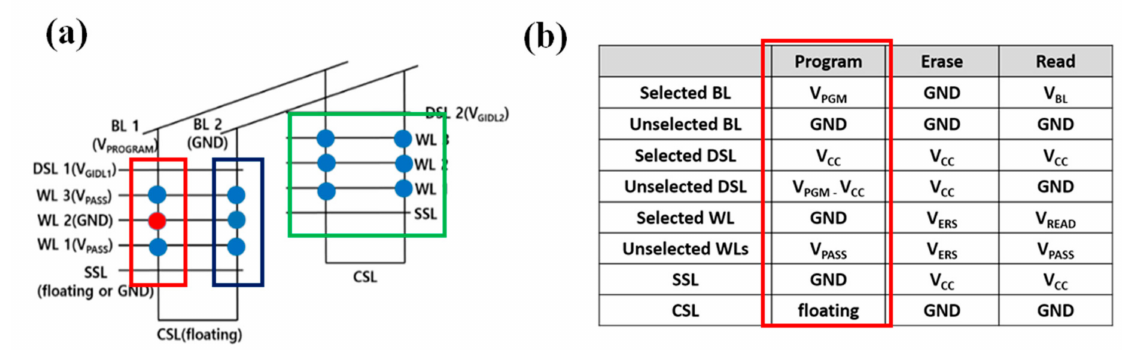
Figure 3. Describe how the ferroelectric V-NAND structure operates in multiple string operations. ( a ) illustrates voltage distribution for programming only a specific cell in the combination of WL2 and BL1, and ( b ) describes the operating voltage of the contacts in each